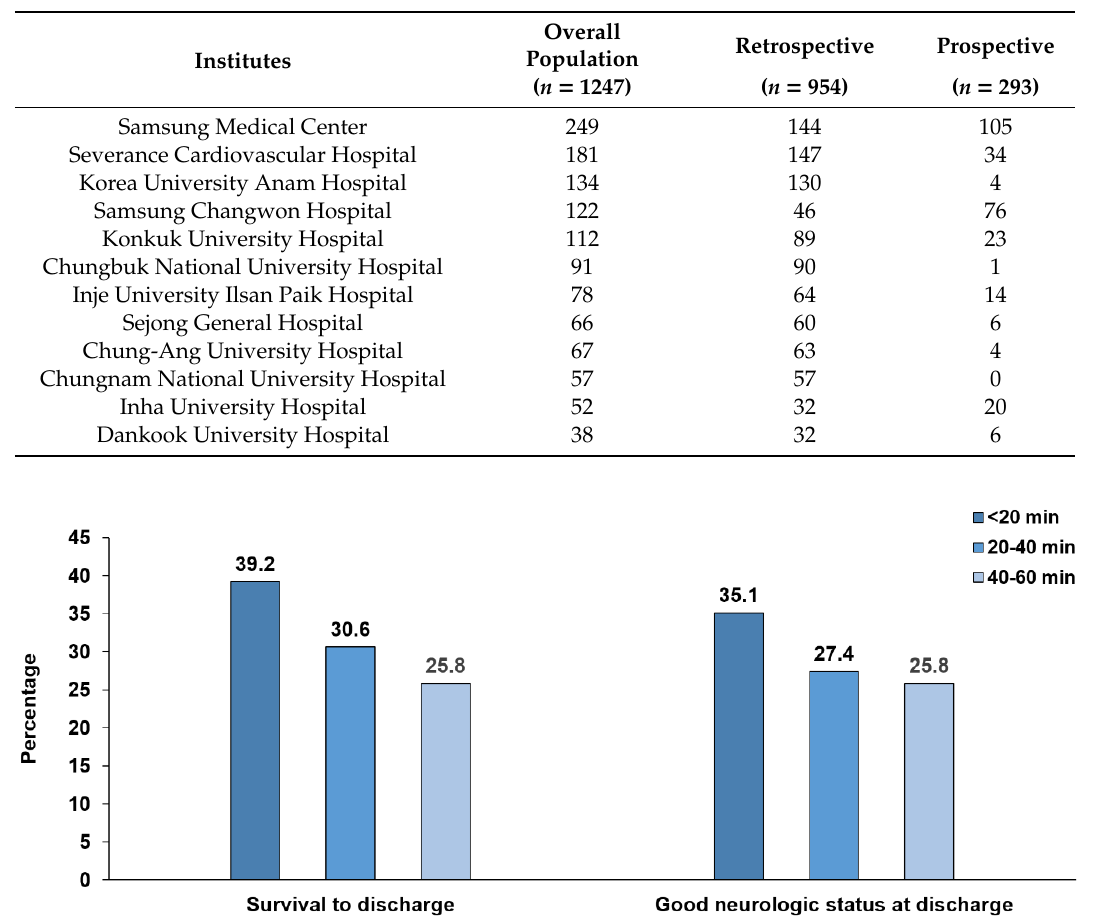
Table A1. Prospective and Retrospective Enrollments of each Institute.